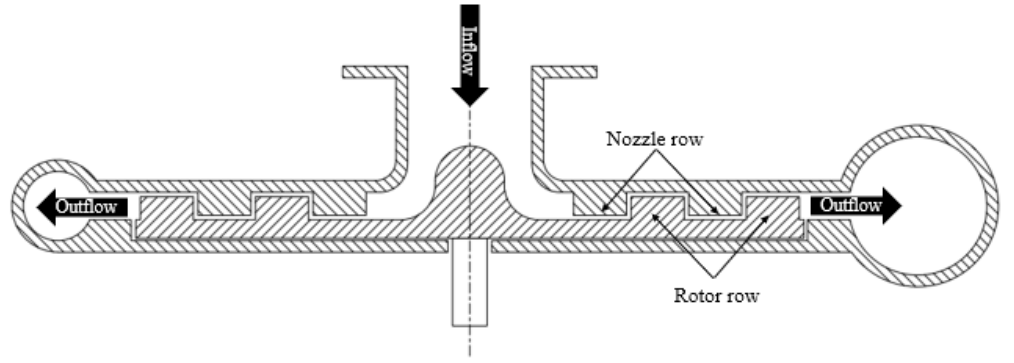
Figure 2. Structure of a radial outflow